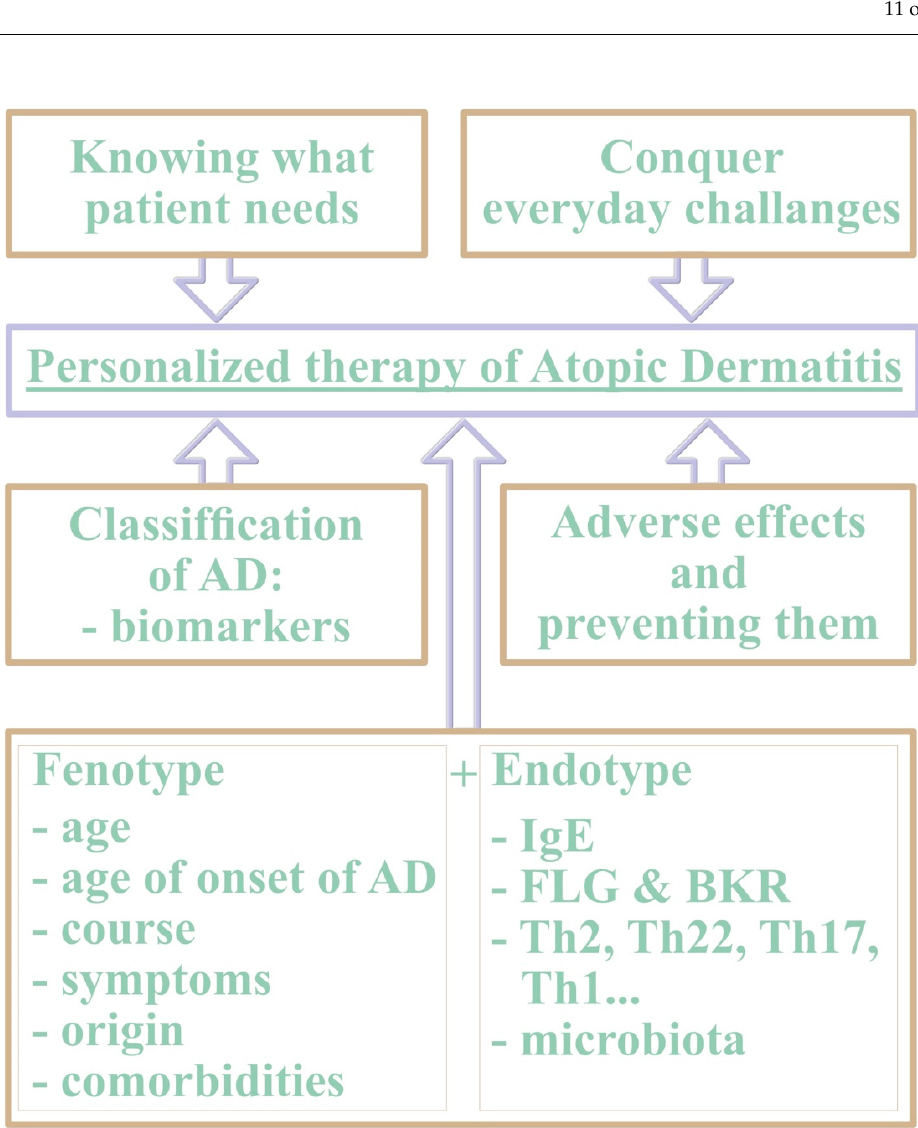
Figure 2. A comprehensive view of the personalized therapy of atopic dermatitis is needed. In